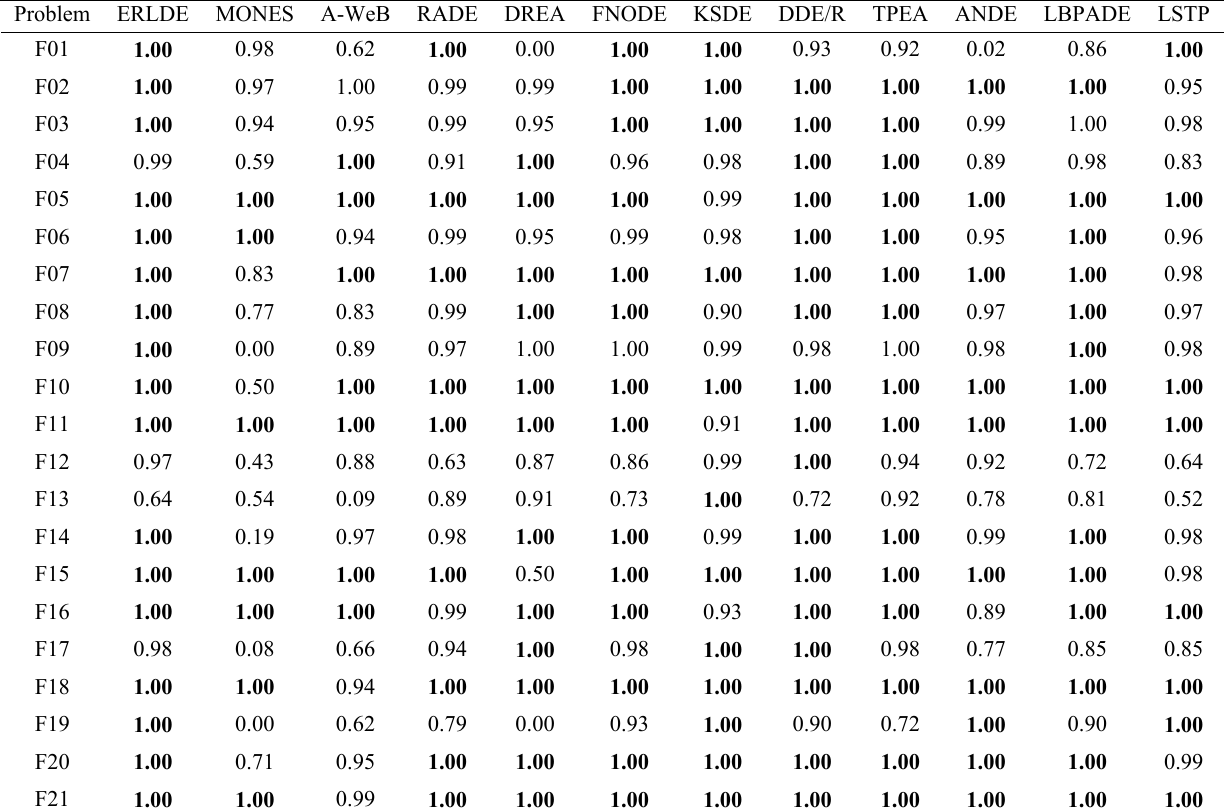
Table A2 Comparison between ERLDE and other algorithm with respect to RR